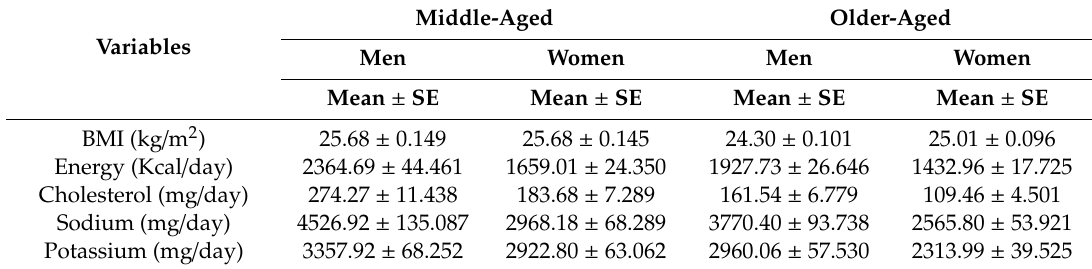
Table 2. Body mass index (BMI) and dietary intake by gender and age (N = 4287).